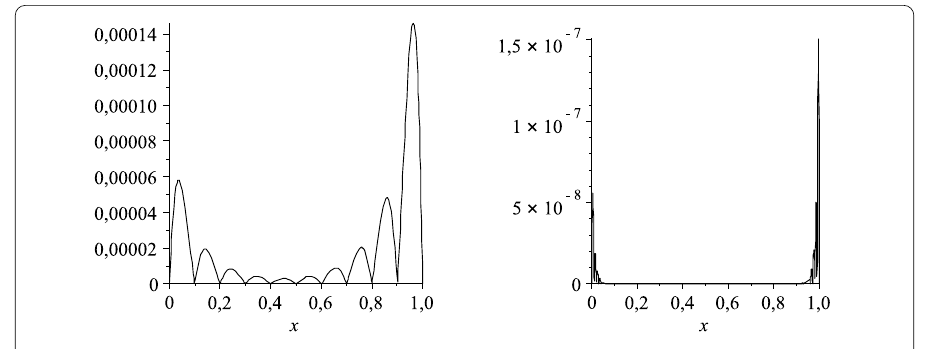
Figure 1 Graphs of absolute errors | f 1 ( x ) – S ( f 1 ; x ) | for N = 10 (left) and N = 100 (right)